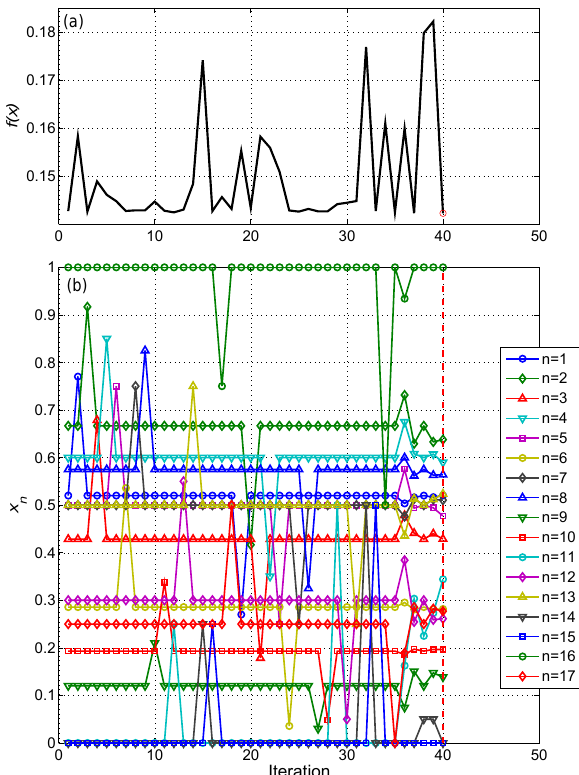
Figure 5. Sequence of objective function values (a) and parameter vector components (b) at each iteration in the 3-month (February– April 1997) ST4 calibration. The red dashed line marks the optimal solution found.